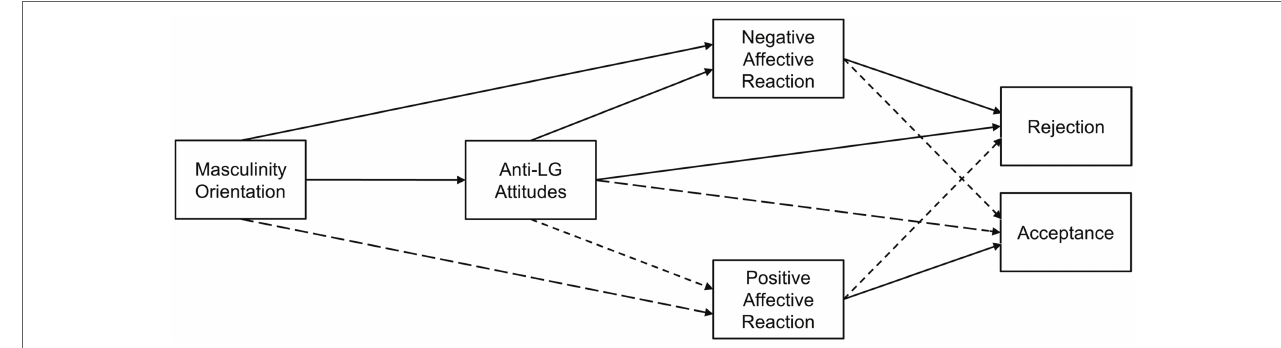
FIGURE 1 | Conceptual mediation model for the association between masculinity orientation and anticipated reactions toward the child’s coming out. Dashed and solid paths indicate hypothesized negative and positive associations,